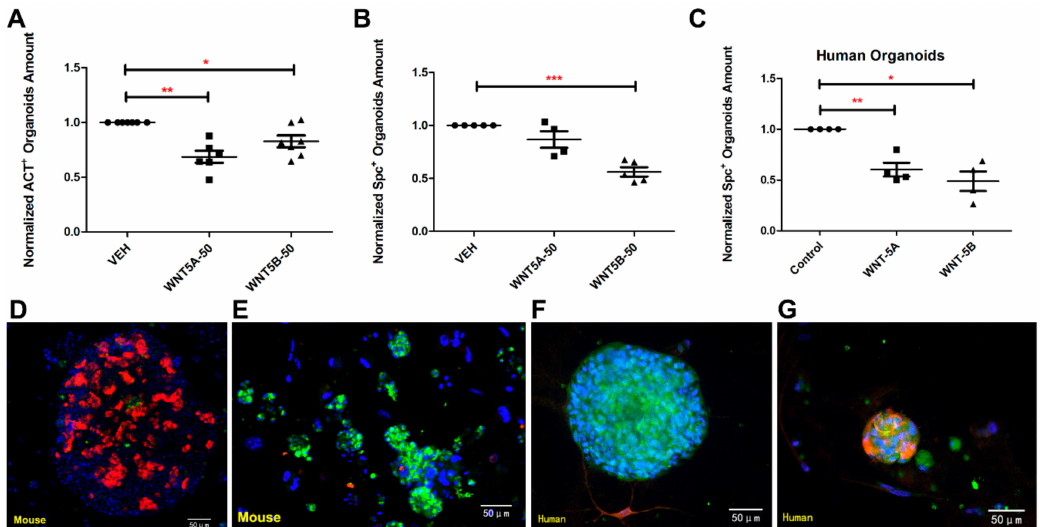
Figure 4. WNT-5A and WNT-5B decreased the amount of acetylated- α tubulin + (ACT + ) organoids and prosurfactant Protein C (pro-SPC + ) organoids. ( A ) E ff ect of WNT-5A and WNT-5B on the murine organoids expressing ACT ( B ) E ff ect of WNT-5A and WNT-5B on the murine organoids expressing pro-SPC. ( C ) E ff ect of WNT-5A and WNT-5B on the human organoids expressing pro-SPC. ( D – G ) Representative immunofluorescence images of murine organoids on day 14, blue (DAPI), green (pro-SPC), red (ACT). Scale bar = 50 µ m. Data are expressed as mean ± SEM, Student t -test, * p <